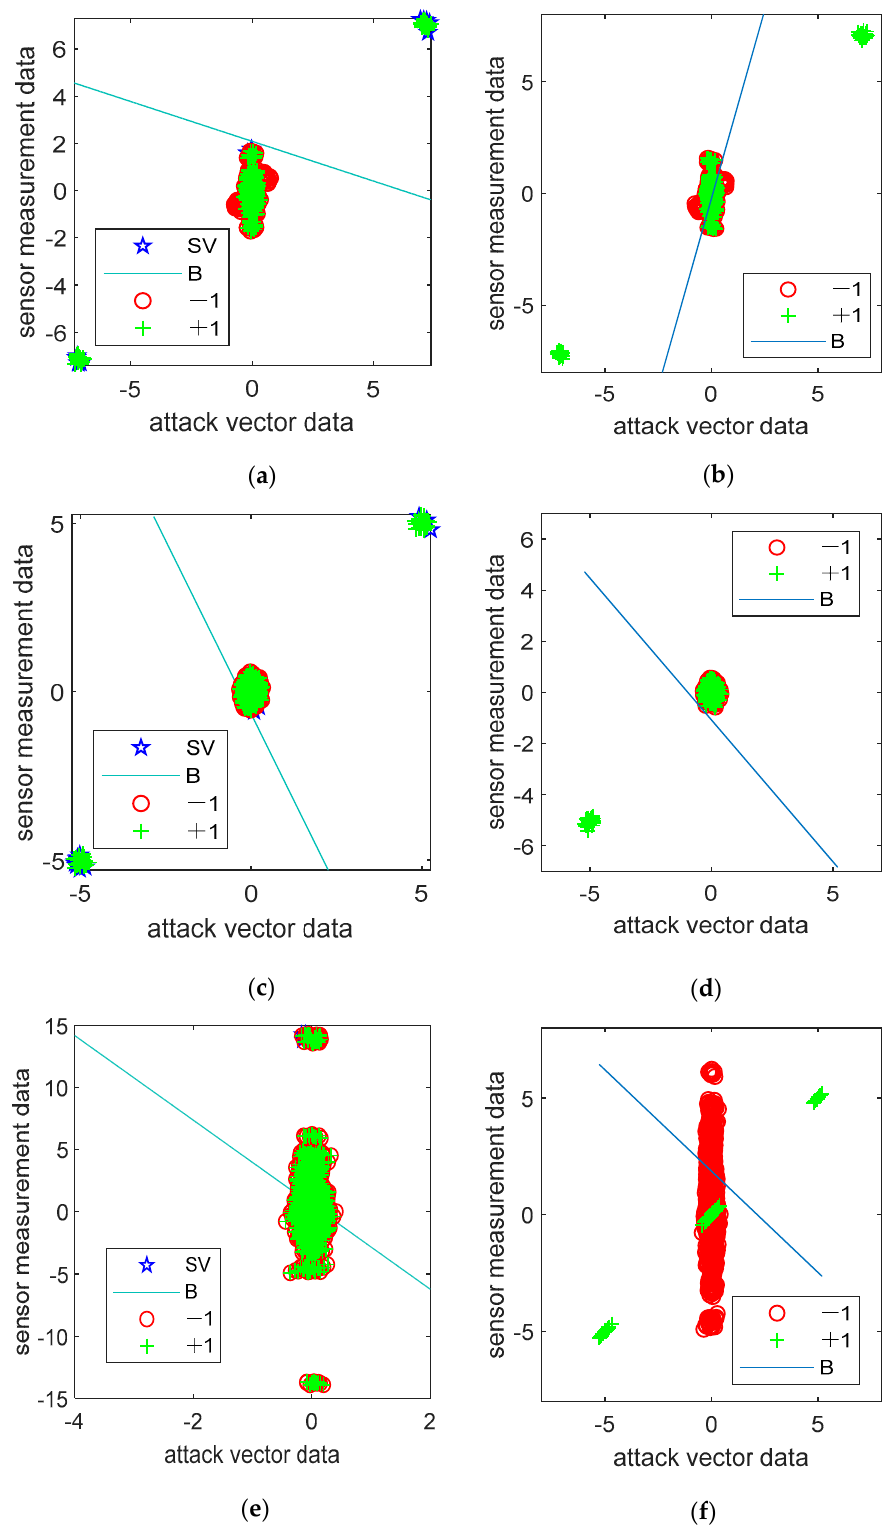
Figure 12. The performance of machine learning methods in the detection of undetectable CCPAs ( a , c , e ), utilizing SVM, and ( b , d , f ), utilizing BP, for an IEEE 14-bus power system, an IEEE 30-bus power system, and an IEEE 118-bus power system, respectively.